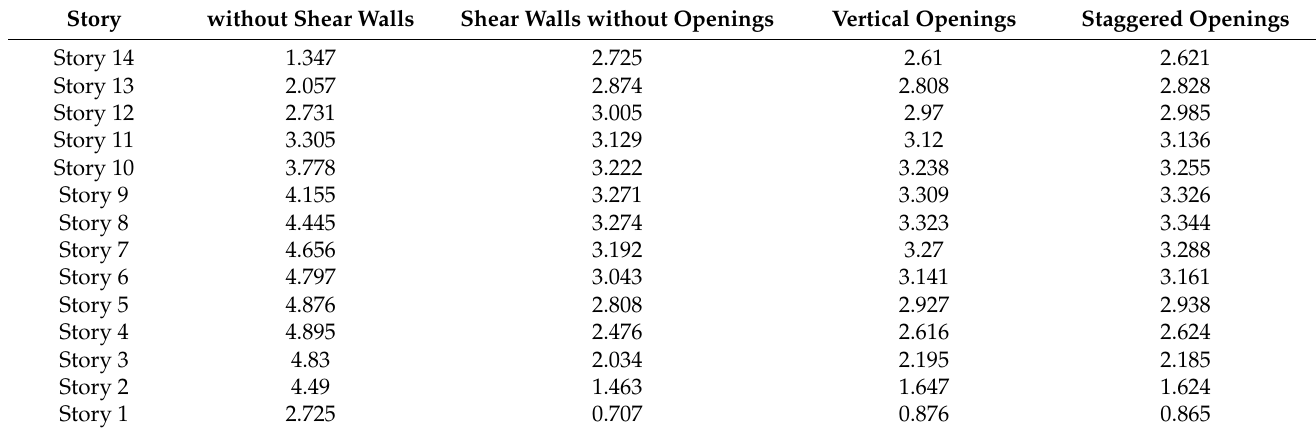
Table 10. Comparison of the measured story drift, static analysis, and X-direction (mm).